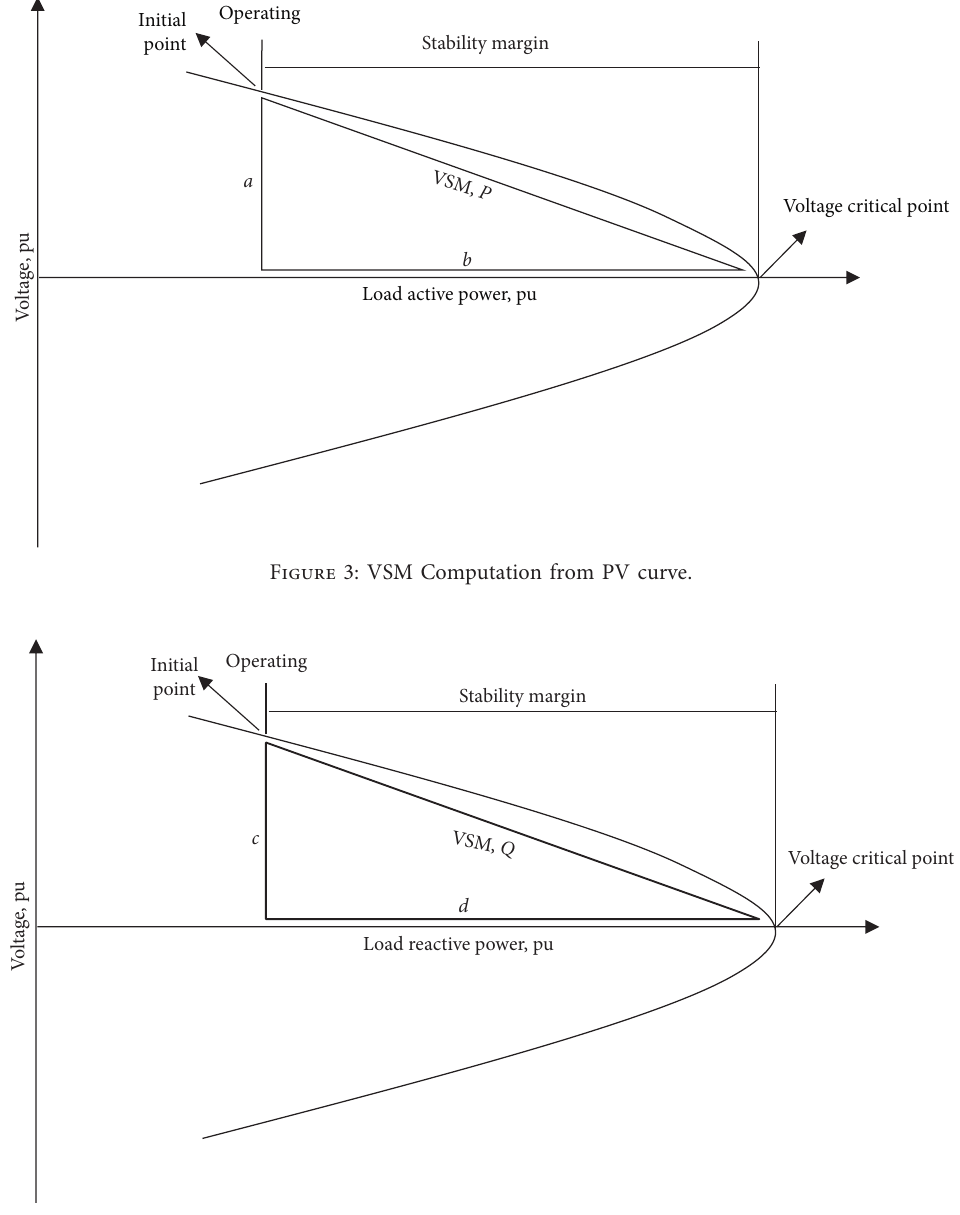
Figure 4: VSM Computation for QV